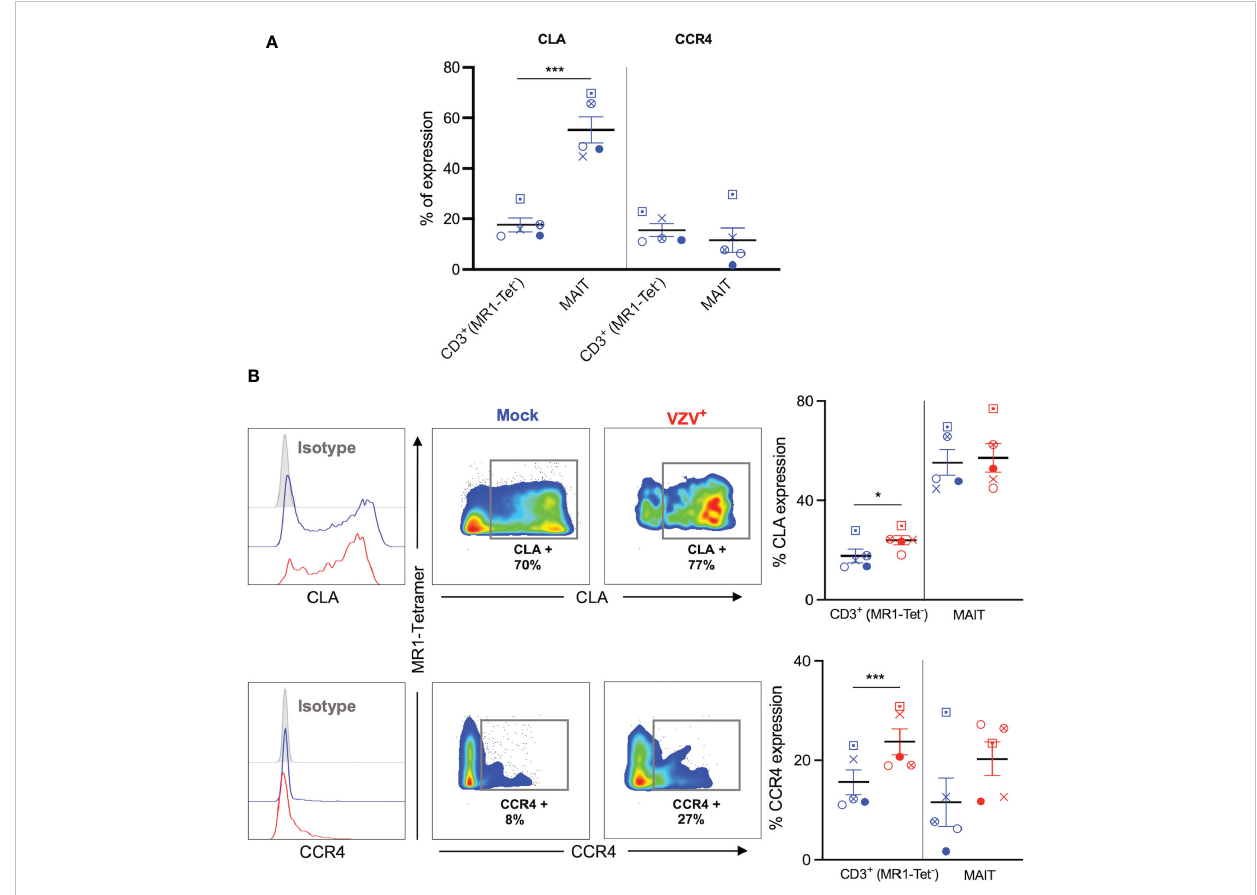
FIGURE 5 VZV infection of MAIT cells retains expression of CLA and CCR4 skin homing chemokine receptor expression. Human PBMCs were inoculated with mock or VZV-S infected ARPE-19 epithelial cells for 2 days and then analyzed for infection (gE:gI), and skin homing markers (CLA and CCR4) by fl ow cytometry. (A) Graph shows comparative frequency of surface CLA, and CCR4 expression in mock inoculated non-MAIT (ie MR1-Tet-) CD3 + T cells and MAIT cell populations, with symbols representing individual donors (n=5). Statistical analysis was performed via two tailed paired t test. ***p<0.001. (B) Representative histograms show expression of CLA and CCR4 by MAIT cells for Mock (blue) and VZV infected (VZV + ) (red) populations corresponding to their respective isotype controls ( fi lled grey). Flow cytometry plots from one donor show surface expression of CLA and CCR4 on MAIT cells for Mock (blue) and VZV infected (VZV + ) (red) populations. Graphs show frequencies of non-MAIT CD3 + and MAIT cells expressing CLA and CCR4 with symbols representing individual donors across the subpopulations, with mean and SEM indicated by the bars. Statistical analysis of CLA and CCR4 expression between Mock and VZV + infected non-MAIT CD3 + and MAIT cells was performed via two tailed paired t test (n=5). *p<0.05,